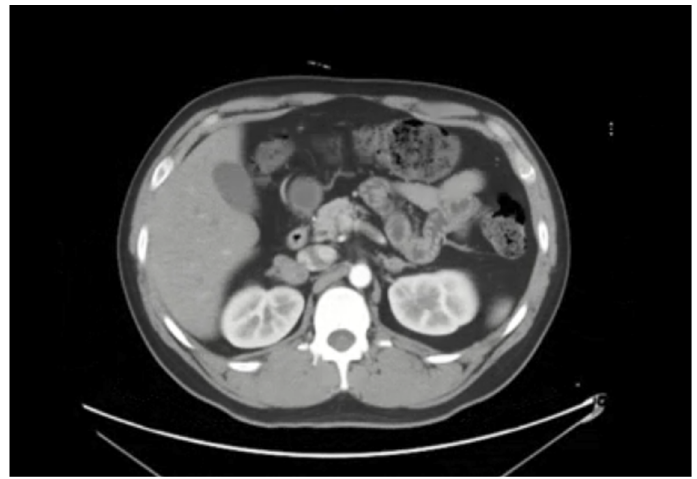
Figure 2. The computed tomography of the proband showed multiple nodules on both sides of the adrenal glands.